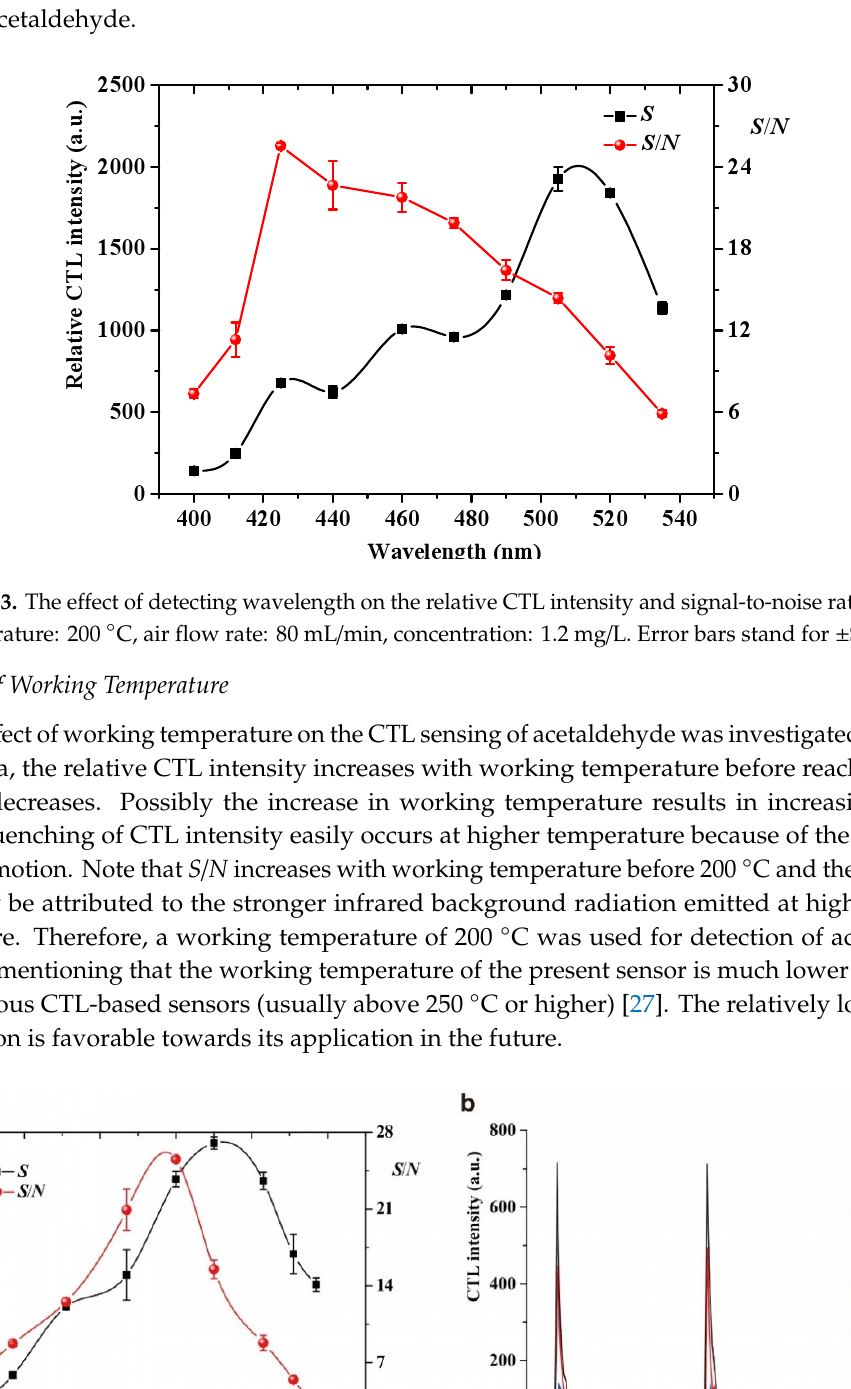
Figure 3. The effect of detecting wavelength on the relative CTL intensity and signal-to-noise ratio ( S / N) . Temperature: 200 °C, air flow rate: 80 mL/min, concentration: 1.2 mg/L. Error bars stand for ±S.D.